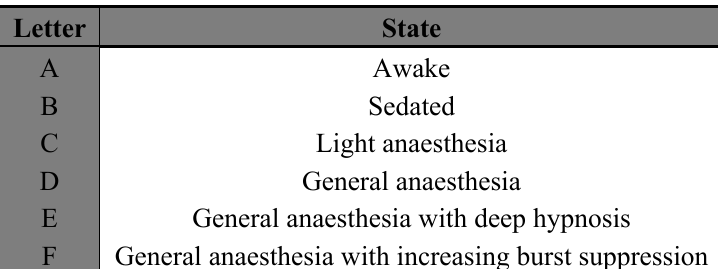
Table 4. The Algorithm Stages of Narcotrend Monitoring Device.